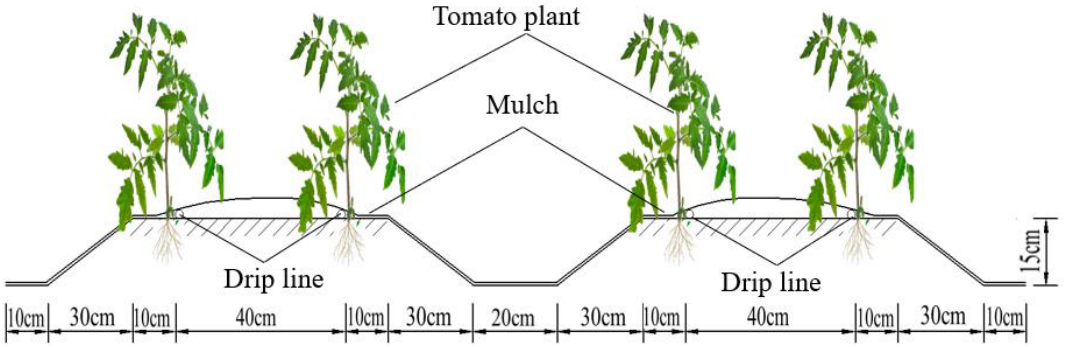
Figure 2. Tomato planting pattern.